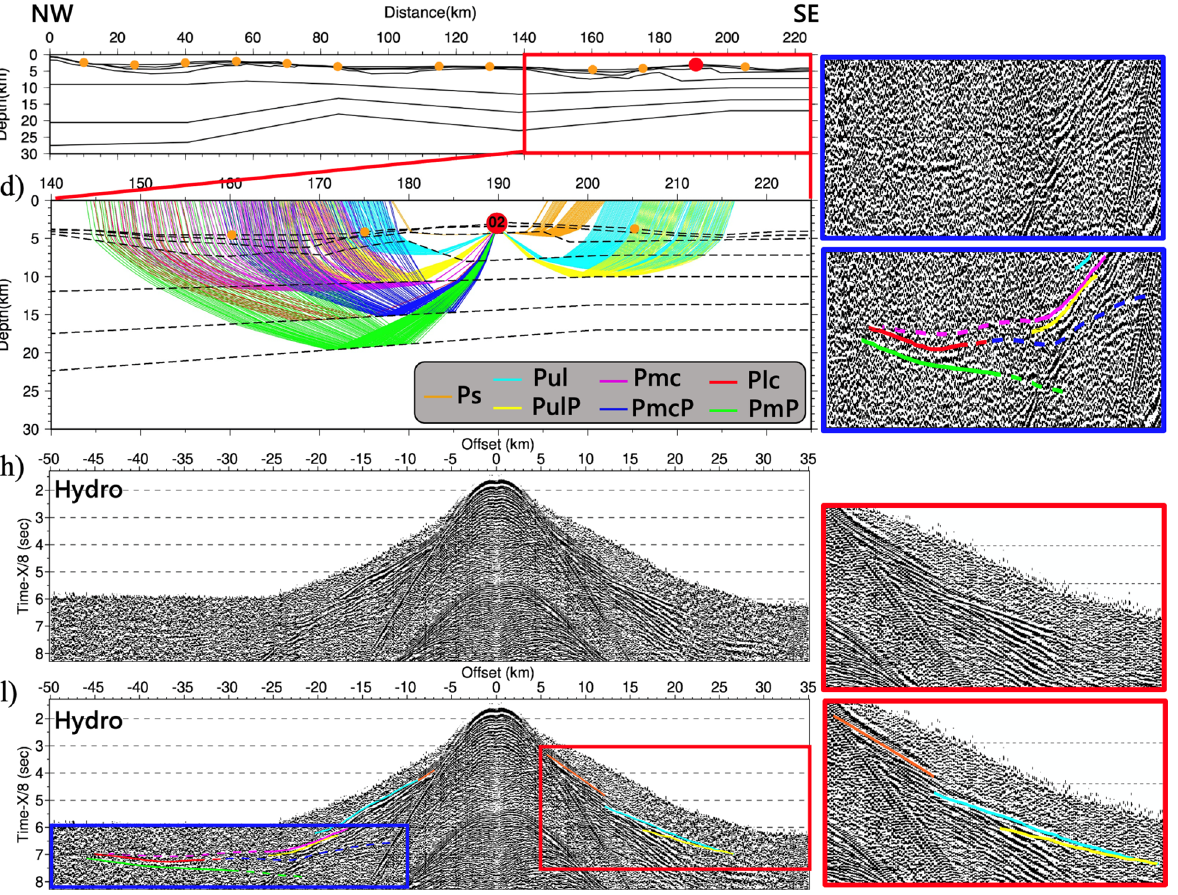
by the NW convergence of the PSP and subsequently converted to normal faults in the eastern portion of the Nanao Basin either by gravity or decoupling of the PSP and the Eurasian Plate (Hsu 2001). Thus, the secondary basement high beneath the Nanao Basin might be slightly uplifted by an asperity (e.g., the subducted Gagua Ridge or a buried volcano) to make the strata differently high from east to west. At the Nanao Basement Rise, the sedi- mentary thickness with a P-wave velocity of 1.6–3.4 km/s (Figs. 5b and Additional file 1: Fig. S6b) is ~ 1 km (Fig. 5b, Additional file 1: Figs. S6b, and 11). This basement high might have been formed by uplifting and been affected by numerous normal faults. These normal faults are cut- ting the uppermost sedimentary layer to reach the sea- floor because the Nanao Basement Rise is still active (Font et al. 2001). At the western Hoping Basement Rise, the west-dipping layers of the old Suao Basin with a sedimentary thickness of ~ 2 km and a P-wave velocity of 3.0–4.5 km/s were imaged (between common depth points of 17,200 and 23,800 in Fig. 3). The old Suao